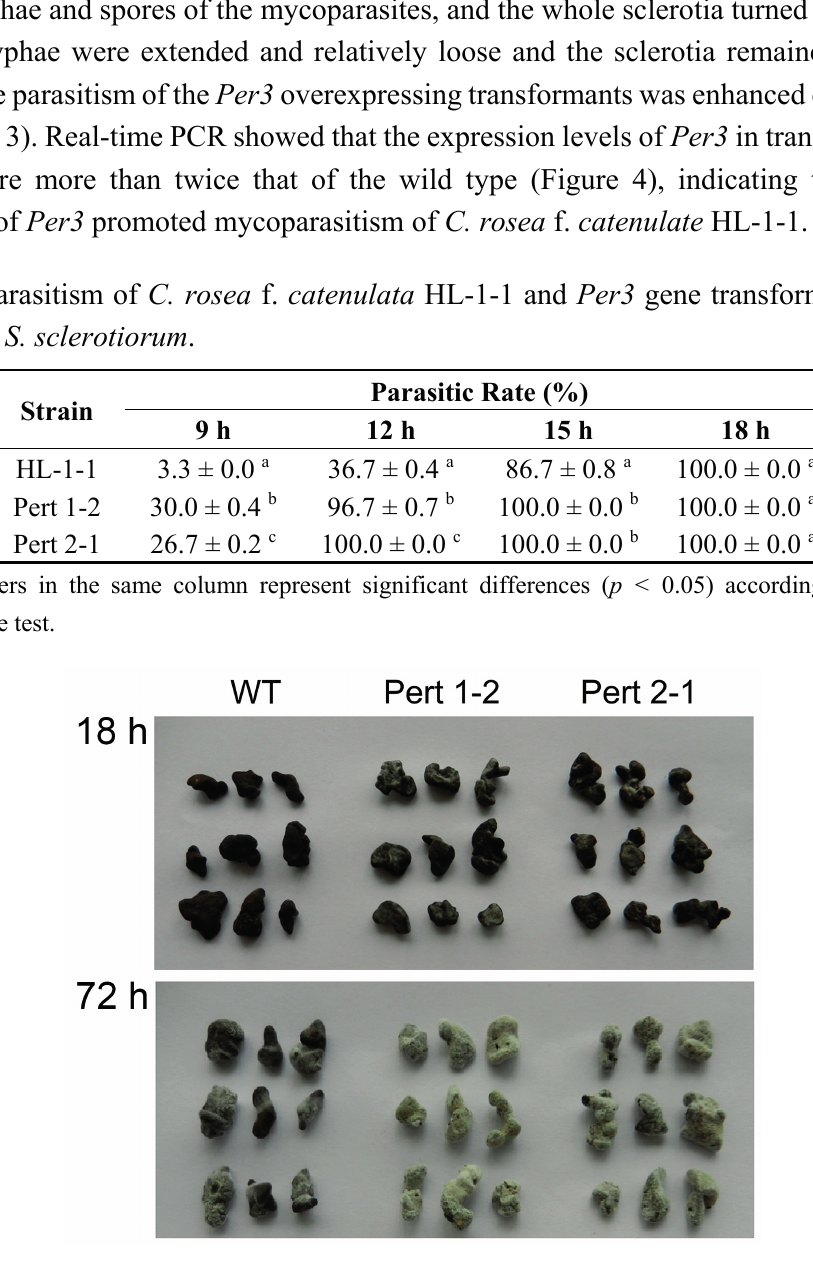
Figure 3. Parasitism of C. rosea f. catenulata HL-1-1 and Per3 gene transformants on sclerotia of S. sclerotiorum at different stages. Note: WT: Wild